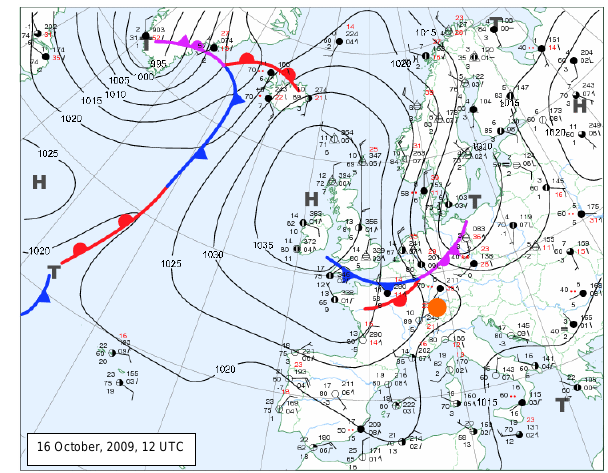
Fig. 6. Typical example of a one-day wind profile time series at Payerne (5 February, 2010). Coloured barbs: wind profiler mea- surements; grey barbs: COSMO-2 profiles (analyses every 3 h fol- lowed by 3 h forecasts); CHA dark grey barbs: 10-ma.g.l. in situ wind measurements on top of the nearby Jura mountain at Chasseral 1600ma.s.l. (for clarity the data display is given only every 2 h; the effective sampling time is 10 min).